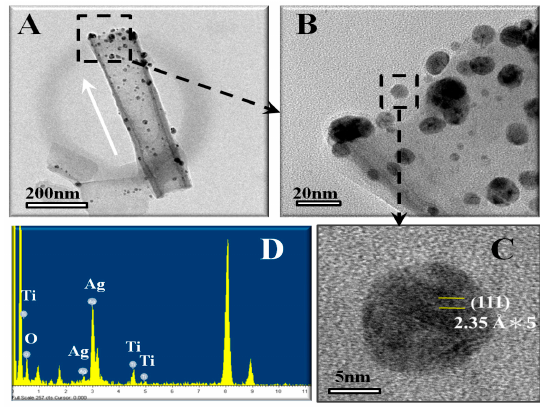
Figure 14. ( A ) TEM image of a single, Ag-decorated TiO 2 nanotube with a diameter of 100 nm. The white arrow indicates the growth direction of a nanotube. ( B ) High-magnification image of the selected are, as marked by a dashed square in ( A ). ( C ) Enlarged view of a single AgNP, and ( D ) the